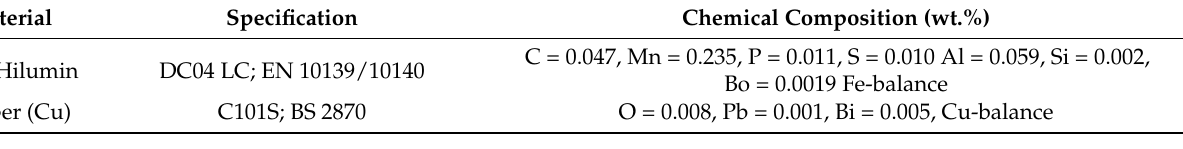
Table 1. Details of materials used in this study.